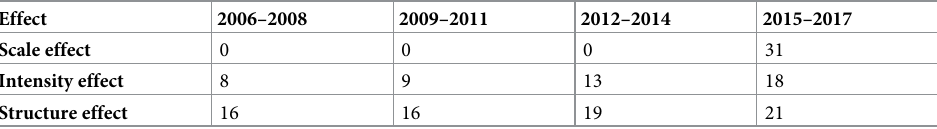
Table 1. Number of provinces with negative effects in each